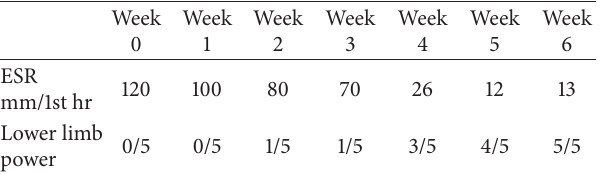
Table 1: Clinical response and change of ESR with time following parenteral and oral ciprofloxacin treatment.